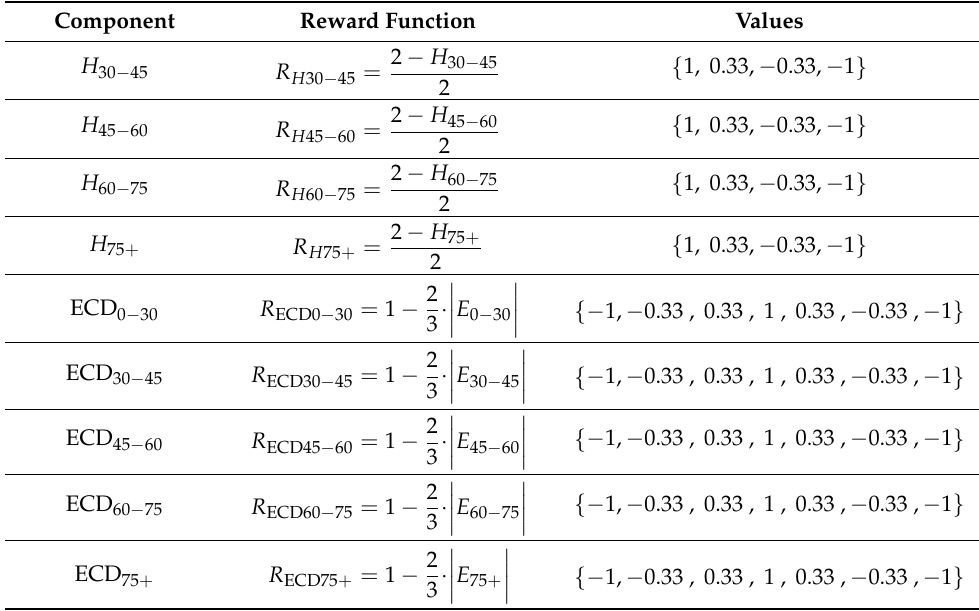
Table 1. Reward function associated with state vector components.